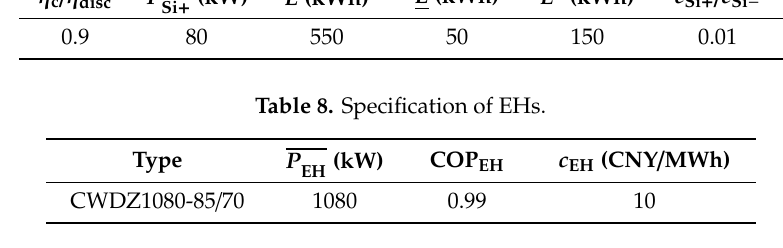
Table 9. Specification of ECs.